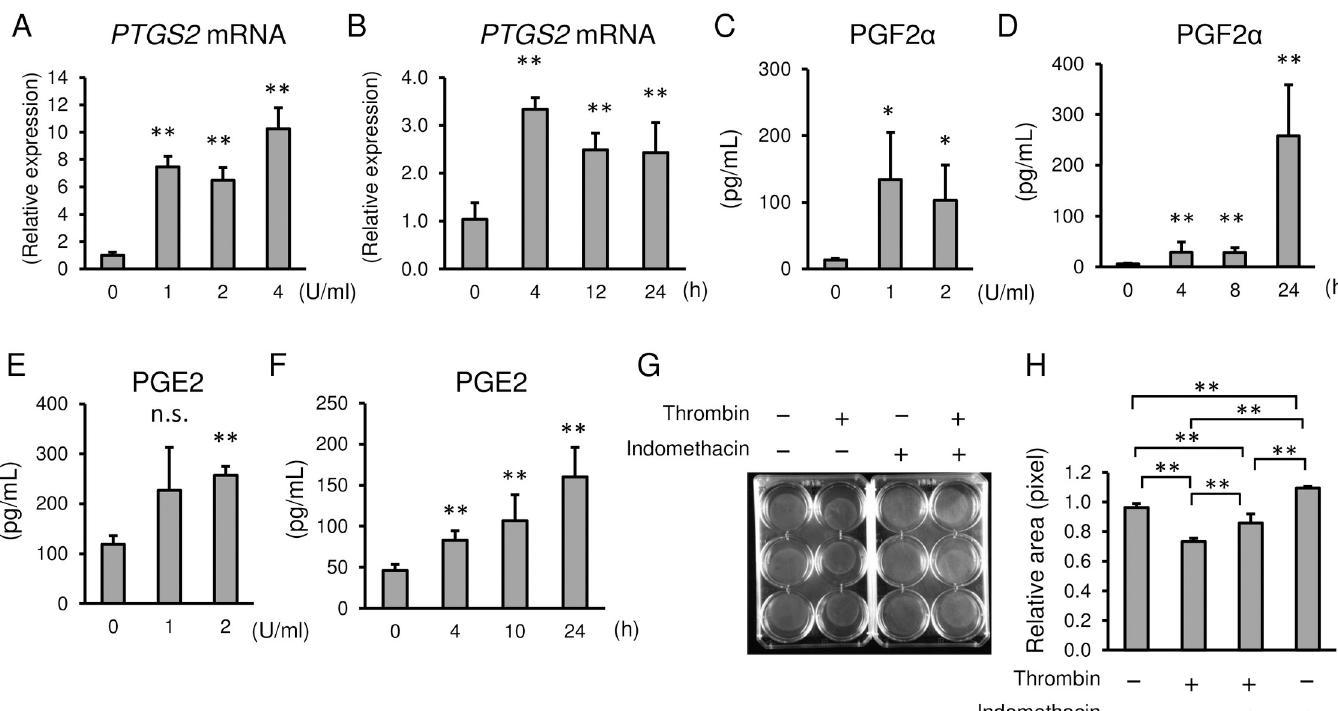
Fig 5. Effect of thrombin on PTGS2 mRNA expression and prostaglandin synthesis in myometrial cells. (A, B) Thrombin-induced increases of PTGS2 mRNA at 24 h with different doses of thrombin (A) , or 2 U/mL of thrombin as a function of time (B) . (C-F) Thrombin-induced increases of PGF2 α (C, D) and PGE2 (E, F) in the media of thrombin-treated cells. Dose-dependent changes at 24 h (C and E) and time course with 2 U/mL of thrombin (D, F). (G and H) Collagen lattice assay of myometrial cells at 30 min with 2 U/mL of thrombin, pretreated with 10 μ M indomethacin for 4 h. (G) Representative image and (H) quantification of gel areas. n = 3 in each group. � , p < 0.05, and �� , p < 0.01. The experiments were repeated three